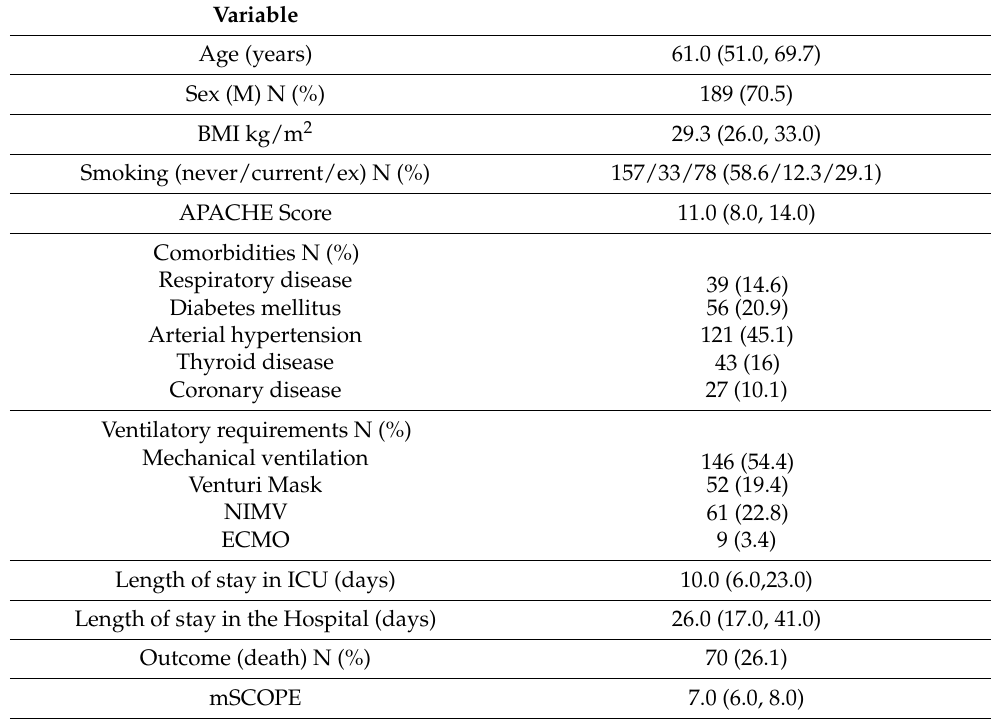
Table 2. Demographic and medical characteristics of the study subjects.